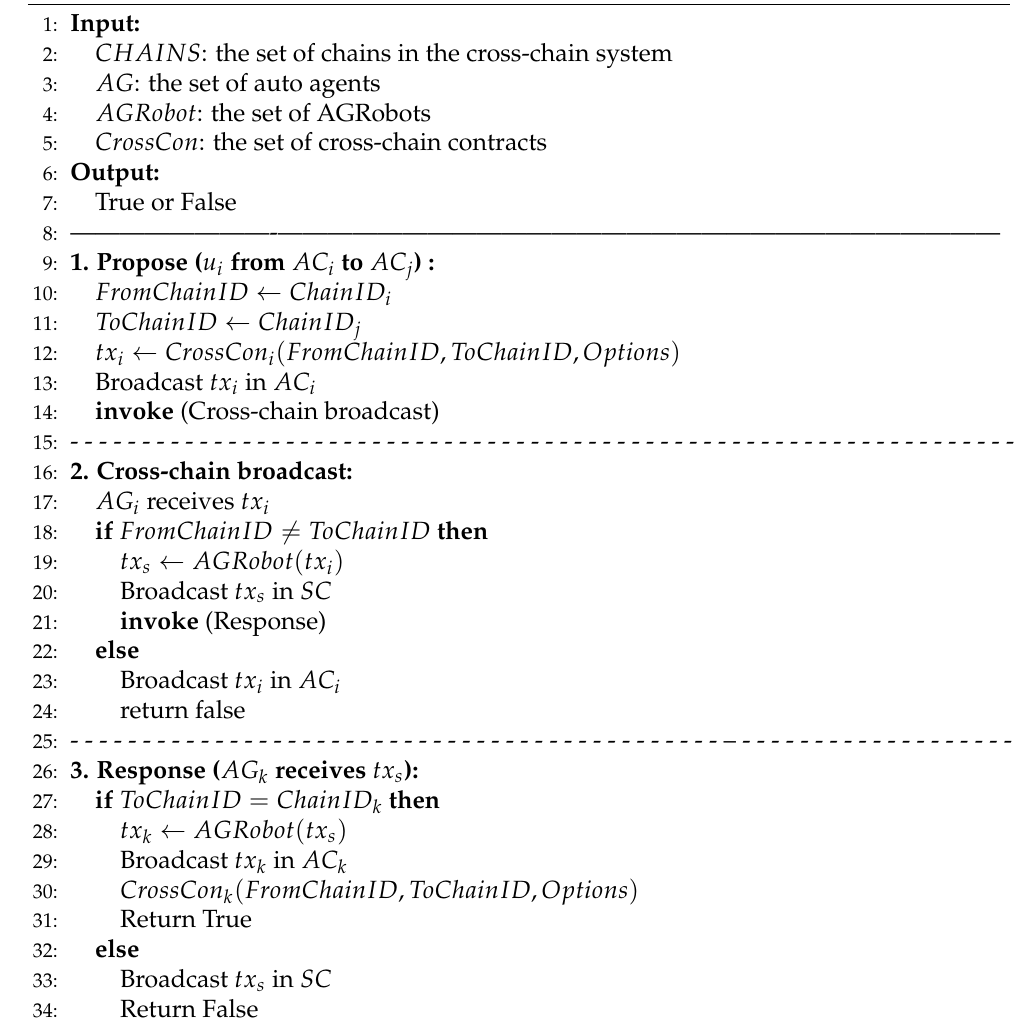
Algorithm 1 Cross-chain data